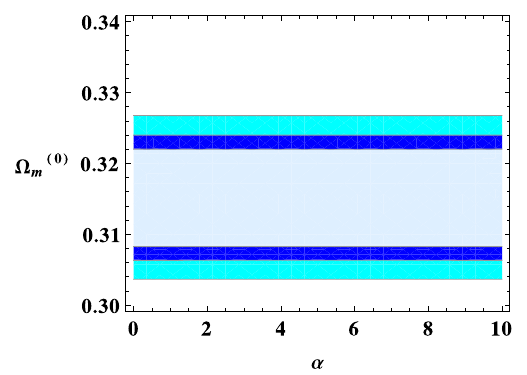
Fig. 10 Observational constraints on the parameters space ( α − (cid:13) ( 0 ) m ) at the 68.3% (light blue), 90% (dark blue) and 99% (cyan) confidence